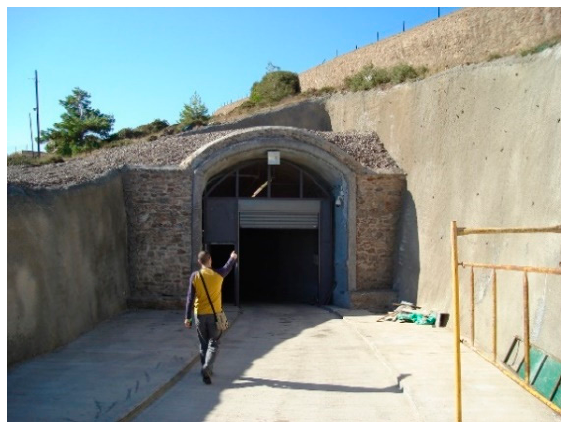
Figure 6. Underground UHWR tunnel exit.